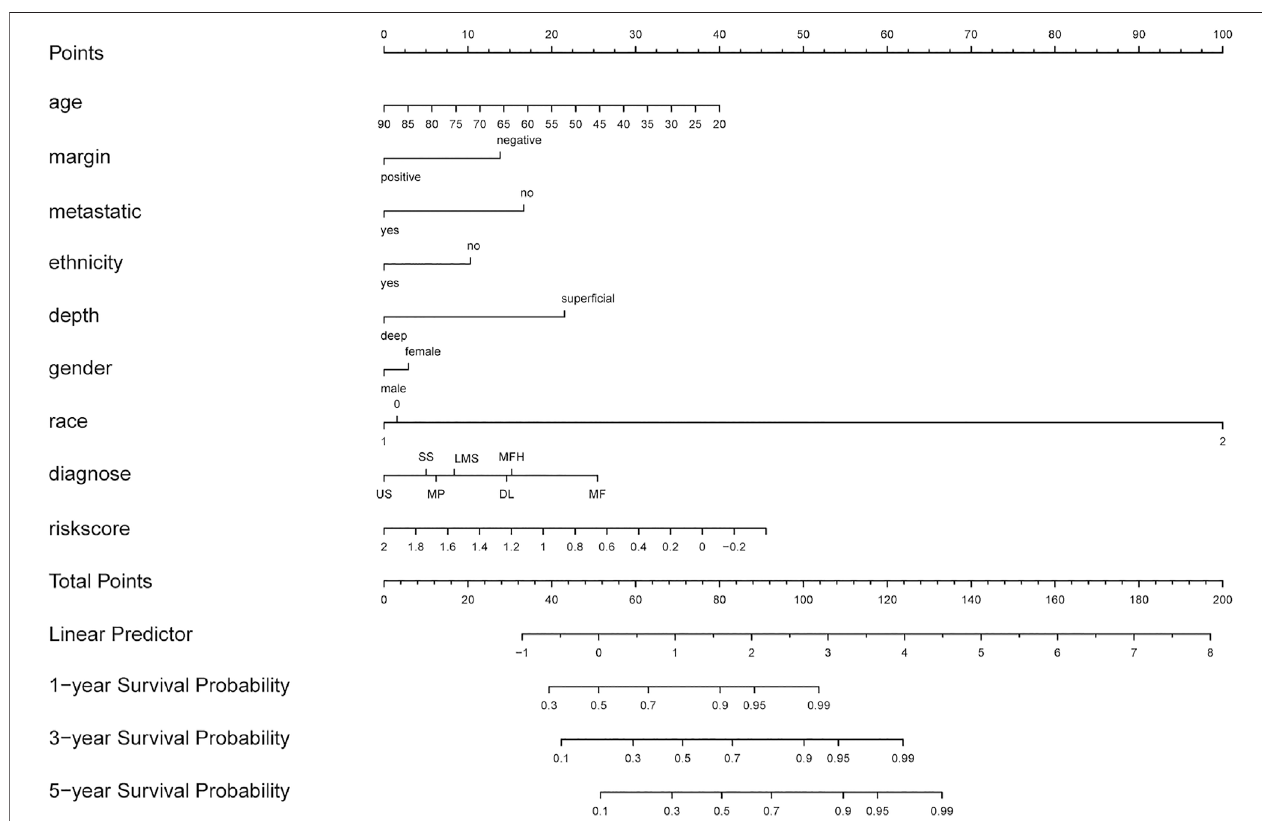
FIGURE 9 | Nomogram combing risk score and clinical factors for prediction of the individualized survival probability of STS patients. In the “ diagnose ” row, LMS (leiomyosarcomas), DL ( dedifferentiated liposarcomas), US( undifferentiated sarcomas), MF(25 myxo fi brosarcomas), MFH(malignant fi brous histiocytomas), MPNST (malignant peripheral nerve sheath tumors), SS( synovial